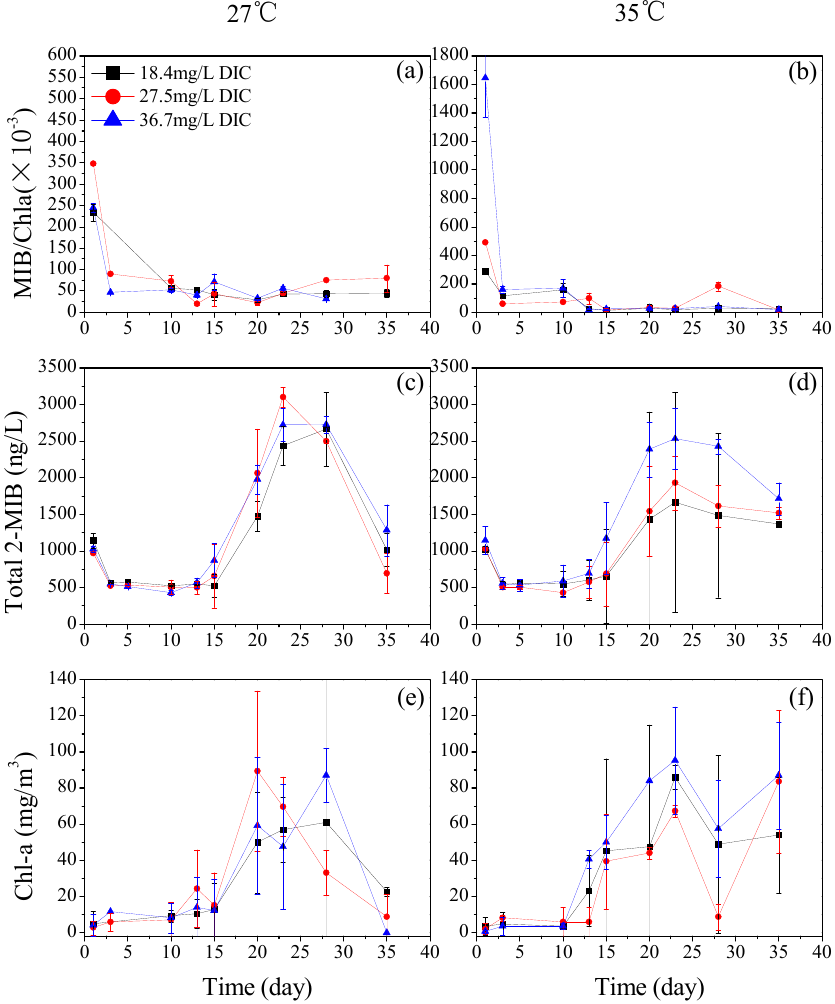
Figure 3. The changes with time in one period of the 2-MIB producing potencial, total concentration of 2-MIB and Chla in three different DIC conditions at 27 and 35 °C: ( a ) 2-MIB producing potencial at 27 °C; ( b ) 2-MIB producing potencial at 35 °C; ( c ) total 2-MIB at 27 °C; ( d ) total 2-MIB at 35 °C; ( e ) Chla concentration at 27 °C; ( f ) Chla concentration at 35 °C.